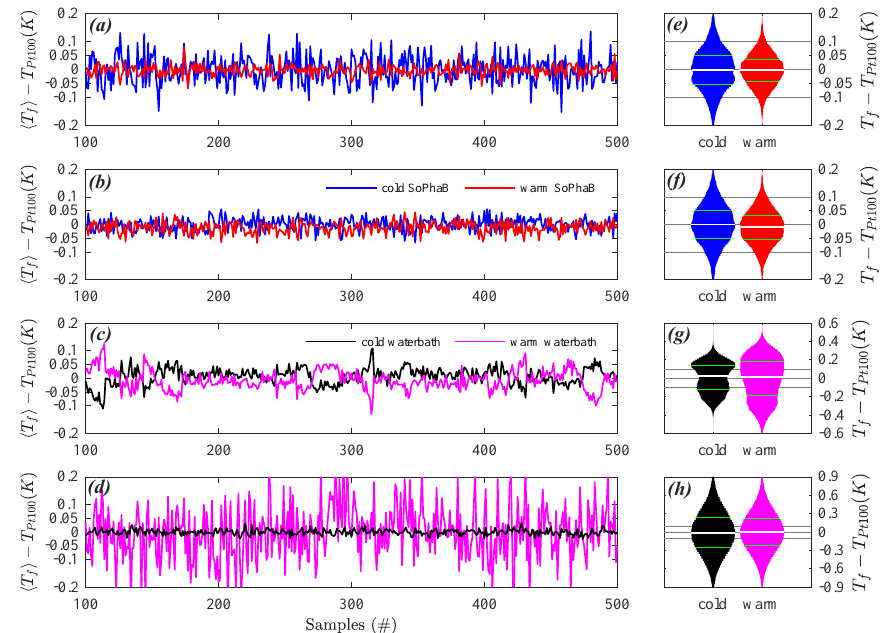
Figure 5. Solid-Phase Bath (SoPhaB) and water bath performance from the constant-temperature field evaluations: Temporal course of the differences between the spatially averaged fiber-optic and reference (Pt100) temperatures for a randomly selected subset of 500 samples ( a – d ), and probability density functions of the their instantaneous deviations for the entire cold and warm reference section ( e – h ) for ( a , e ) Arctic polarnight, ( b , f ) Urban summer, ( c , g ) Arctic pier, and ( d , h ) Grass summer. In violin subplots ( e – h ), the surface areas were normalized by the number of samples for each experiment. Horizontal grey lines are provided for zero and ± 0.1 K for reference. The interquartile range is marked by the 25% and 75% percentiles (green short line), and the median (white short